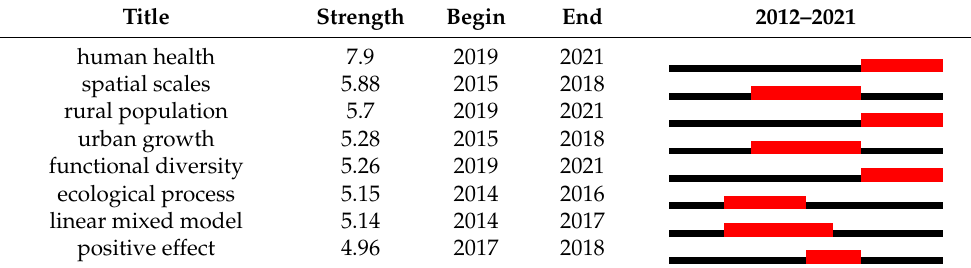
Table 6. Top 10 productive countries or regions from 1990 to